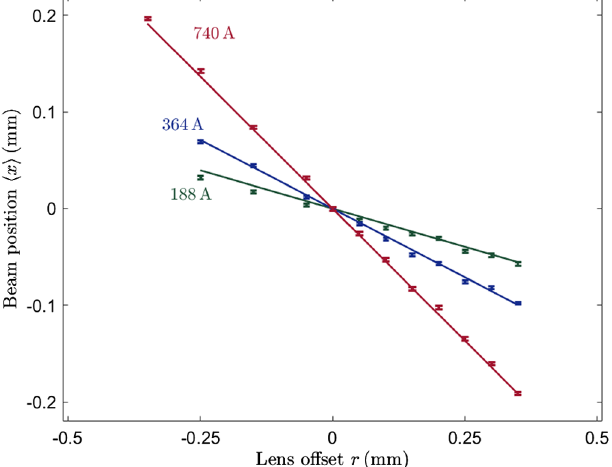
FIG. 3. Results from offset scan using I 0 ¼ 188 , 364, and 740 A of total current. The lines are linear fits to the data. The error bars include statistical fluctuations and underline the stability of the APL setup.